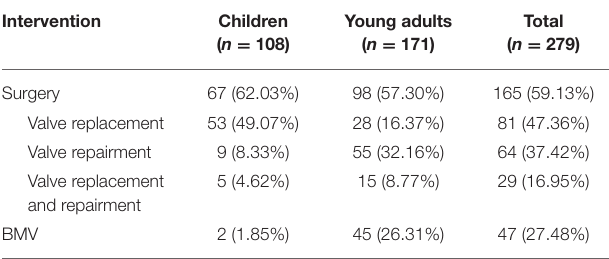
TABLE 4 | Pattern of valve involvement and type of lesions in RHD patients. TABLE 5 | Management of rheumatic heart